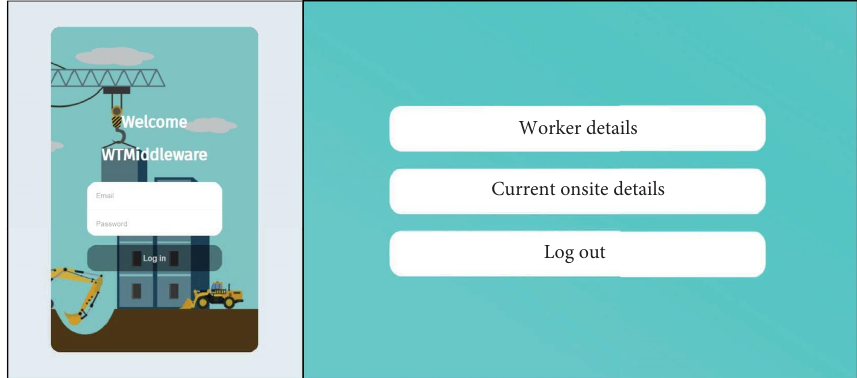
Figure 20: Login interface for supervisor and start-up